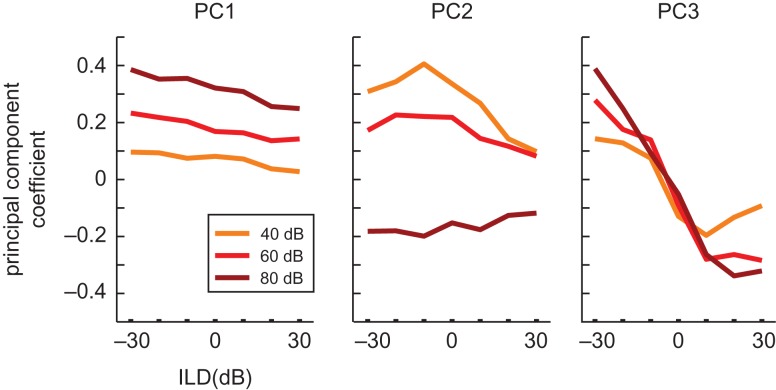
Principal components analysis of the neural population responses. The eigenvectors of the first (left), second (center), and third (right) principal components of all noise-responsive neurons are plotted as a function of stimulus ILD. Sounds presented at the 3 different ABLs are plotted separately and color-coded. This demonstrates the effects of ILD and ABL explained by each principal component.